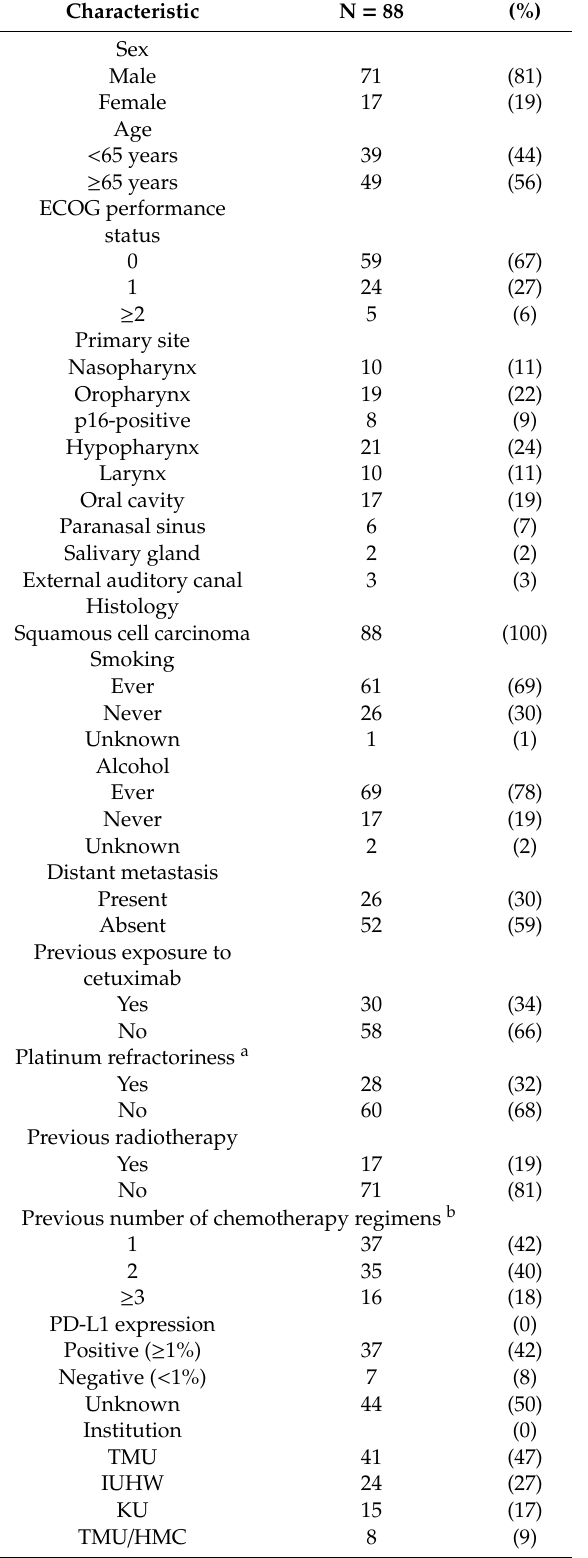
Table 1. Patient characteristics at